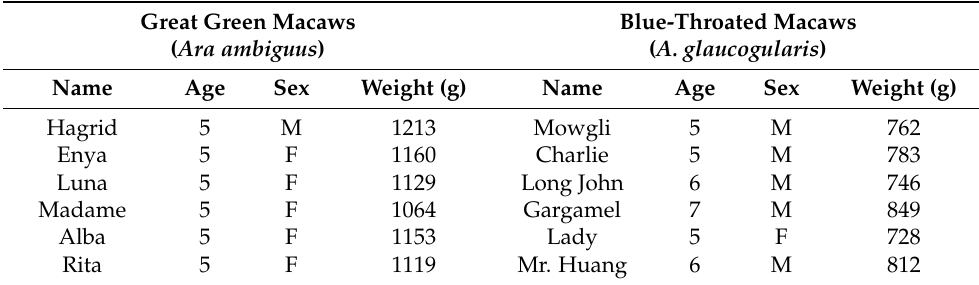
Table 1. Individual characteristics (name, age, sex, and mean weight in grams) for each species. Note that the mean weight is the average of the weights taken during the regular health checks over the study period (August 2019 to March